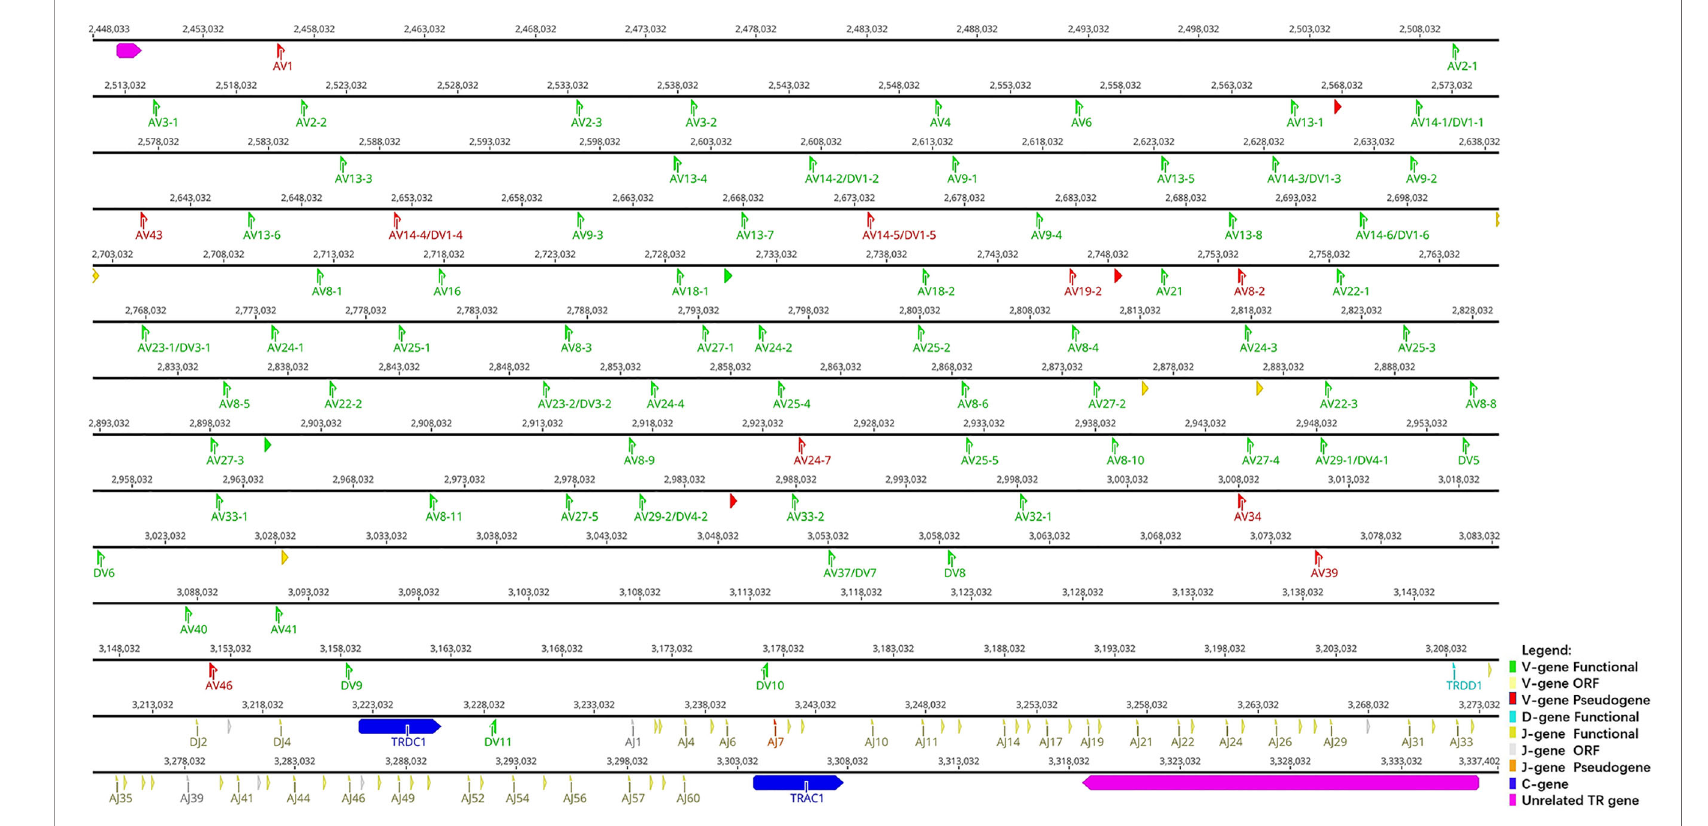
FIGURE 2 | The schematic representation of the genomic organization of the bat TRA/D locus. The diagram shows the position of all the related and unrelated TRA/D genes according to nomenclature. The L-part and RSSs are not shown. The arrows indicate the transcriptional orientation of the genes. The number represents the speci fi c location of the genes in chromosome 6 of Rhinolophus ferrumequinum